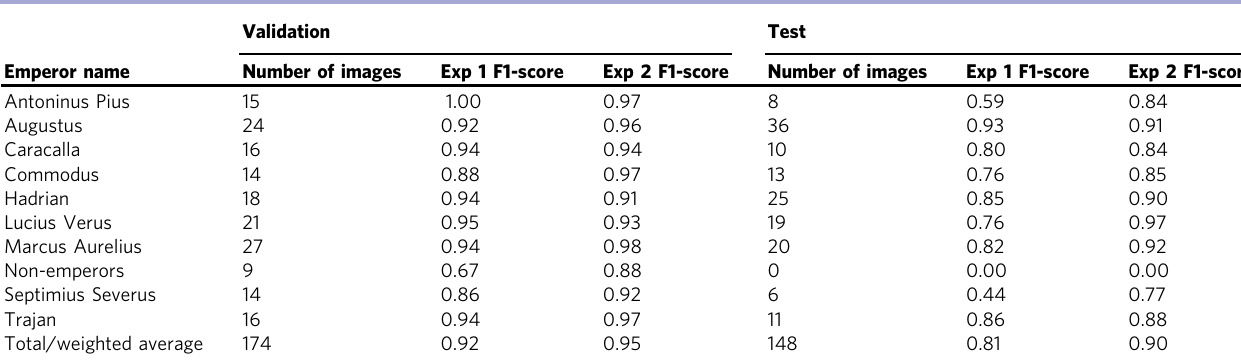
Table 3 F1-scores per class of validation and test